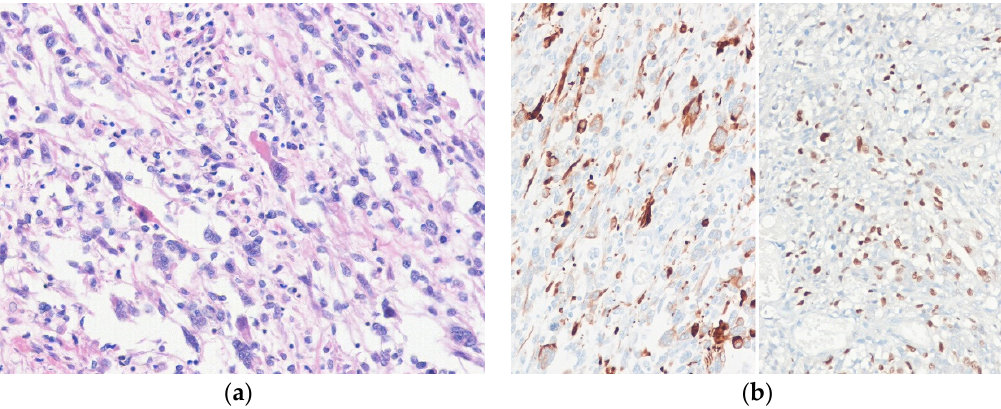
Figure 7. Embryonal rhabdomyosarcoma. ( a ) The tumor is composed of primitive round to spindle cells and eosinophilic rhabdomyoblasts. ( b ) The tumor cells are positive for desmin (left) and myogenin (right) (H&E stain, original magnification 200× a ; desmin and myogenin immunostain, original magnification 200× b